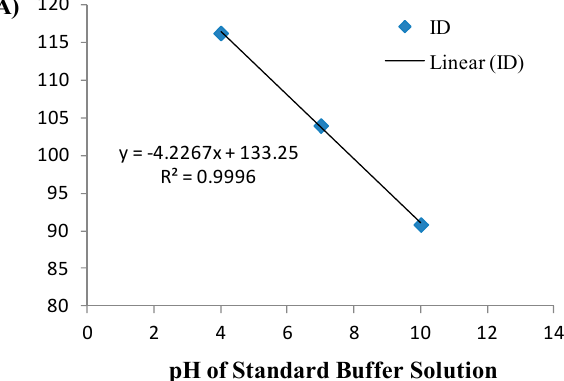
Figure 3. Amperometric calibration curve.